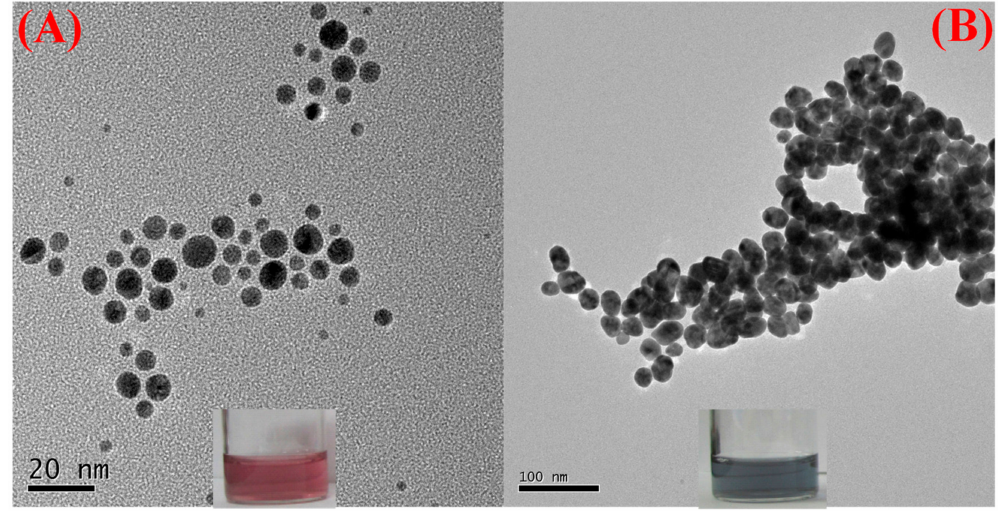
Figure 2. TEM images of PEG / Hg 2 + –AuNP system in ( A ) absence and ( B ) presence of creatinine, inset: photographs of PEG / Hg 2 + –AuNP solution in ( A ) absence and ( B ) presence of